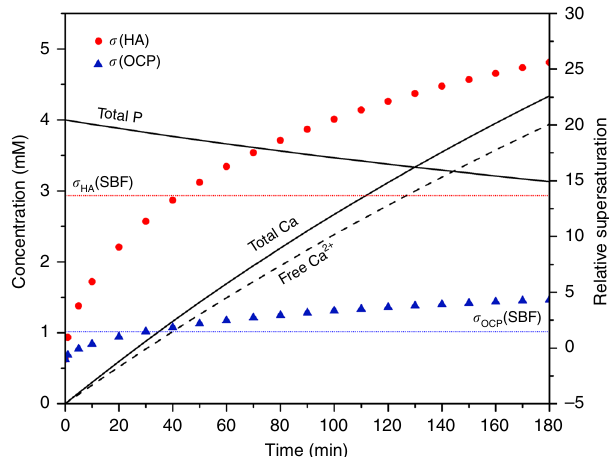
Fig. 7 Theoretical calculation of solution supersaturations. The evolution of total Ca, free Ca 2 + , total P concentration, and relative supersaturation σ HA and σ OCP as a function of time is calculated assuming no solid precipitates during titration. The difference between total Ca and free Ca 2 + is predominately attributed to the complexation in the form of [CaHPO 4 ] 0 . Both HA and OCP become supersaturated within 6 min of titration. σ HA and σ OCP of standard SBF at testing conditions are given in two horizontal dotted